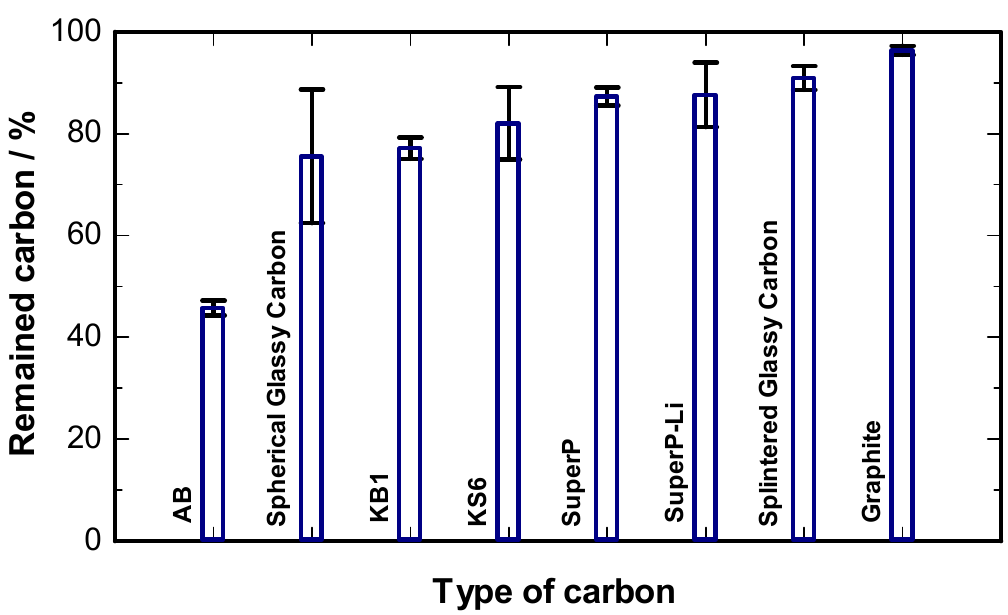
Figure 5. Remaining carbon percentage of cathodes using di ff erent types of carbon after the carbon stability test.